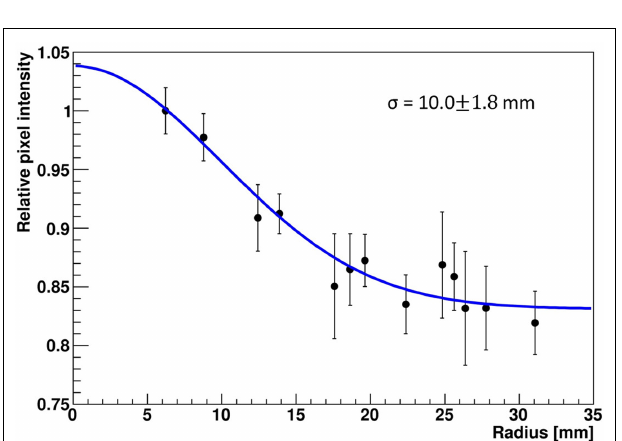
FIGURE 9 | Radial projection of the 2D light amplitude distribution derived from a central irradiation position of the reflectively wrapped LaBr 3 :Ce detector . The blue curve represents a Gaussian fit to the data, the resulting width (cid:27) is indicated.